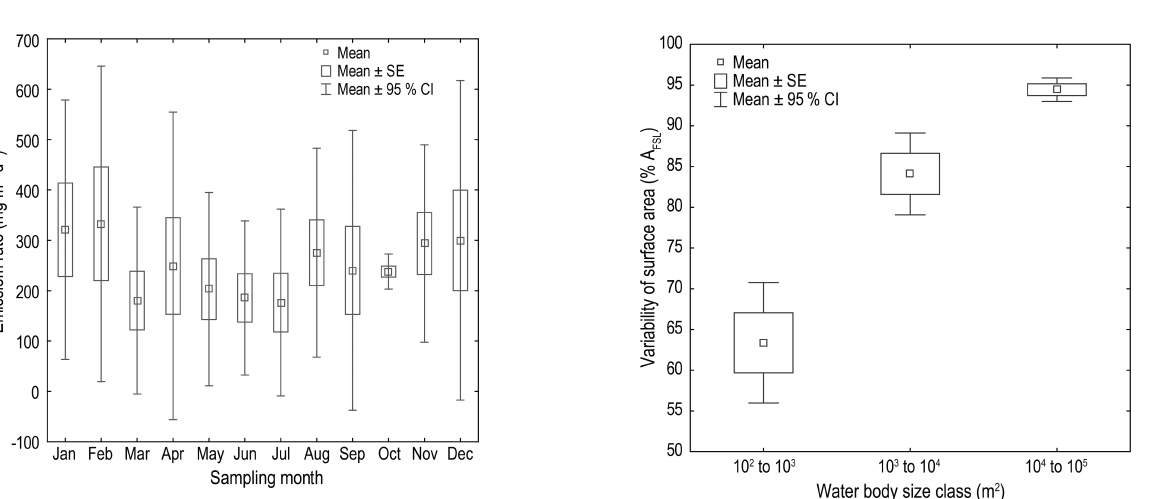
Figure 6. Variability in water surface area as a percentage of A FSL between three GRanD database size classes of ponds. Values indi- cate mean surface area ± SE (standard error) and 95% CI (confi- dence